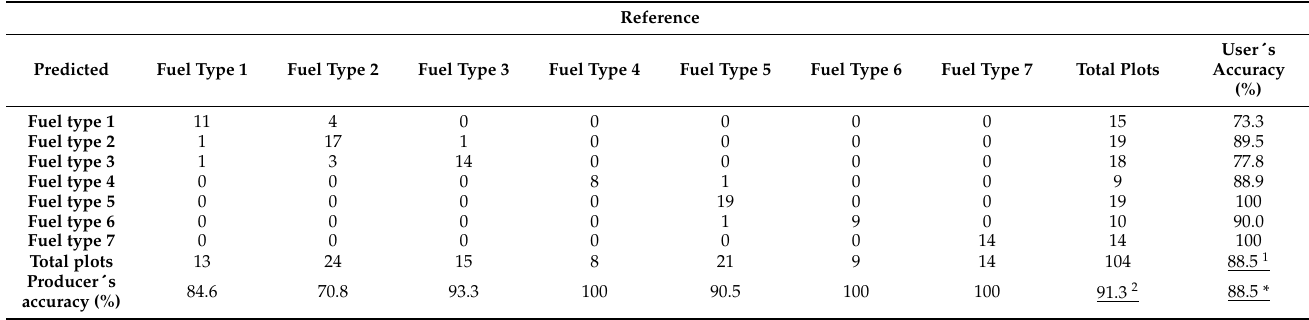
Table 10. Confusion matrix for the most accurate classification model after validation for year 2011. * Overall accuracy, 1 Mean user ´ s accuracy, 2 Mean producer accuracy.